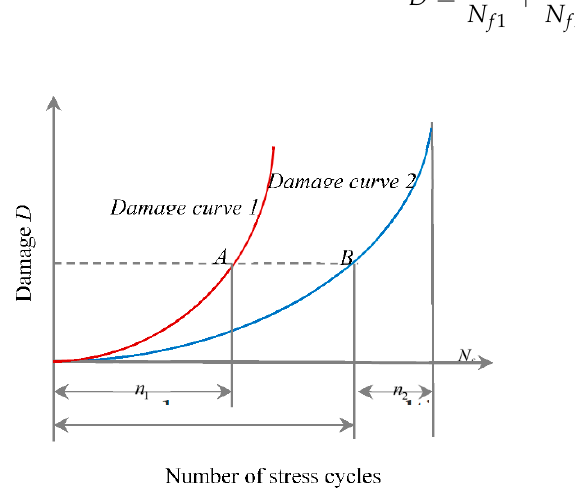
Figure 1. Cumulative damage under multi-stage loading.